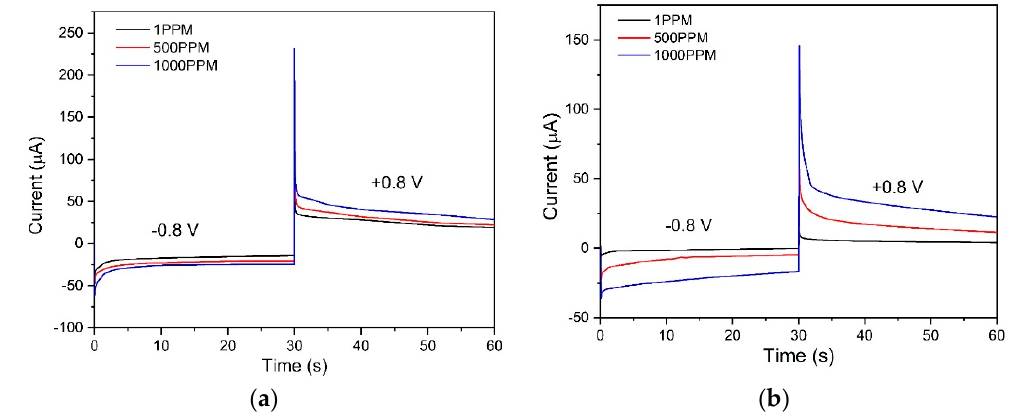
Figure 6. Double potential chronoamperometry scan was performed at − 0.8 V for 30 s and + 0.8 V for 30 s on the [EMIM][BF 4 ]-nafion modified interdigitated electrode (IDE) for the two target analytes. Calibrated dose response chronoamperograms of ( a ) 2,6 DNT and ( b ) ENB which varies with concentration.